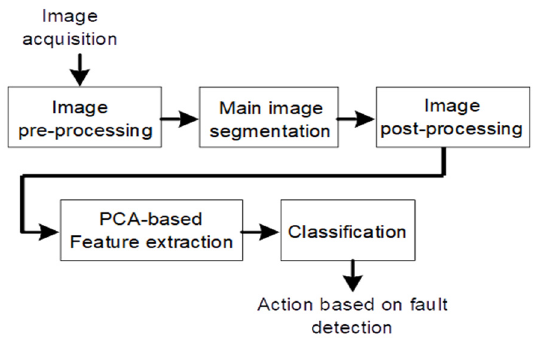
Figure 3. Main steps associated with the proposed